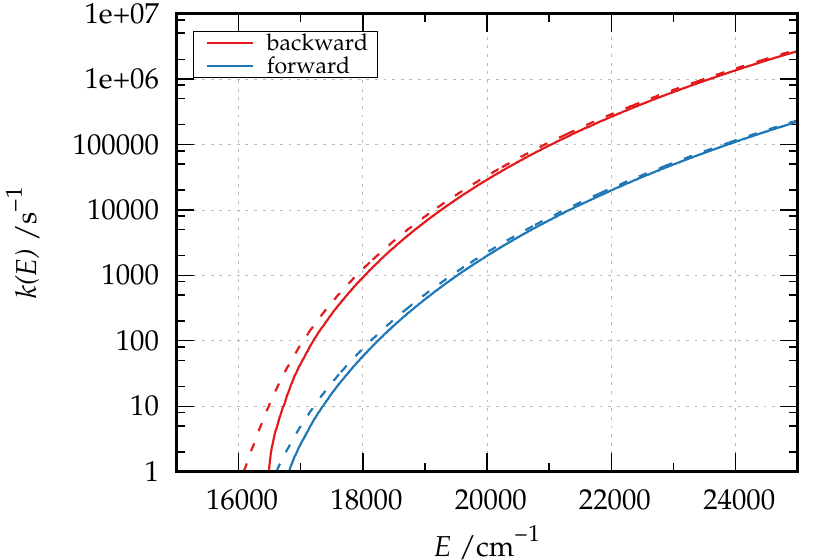
Figure 4. Microcanonical rate coefficients for the backward (red color) and forward (blue color) isomerization reaction of hydroxyacetone and 2-hydroxypropanal (Figure 3) as a function of the energy relative to the reactant zero-point energy. Dashed lines are the tunneling-corrected versions of the rate